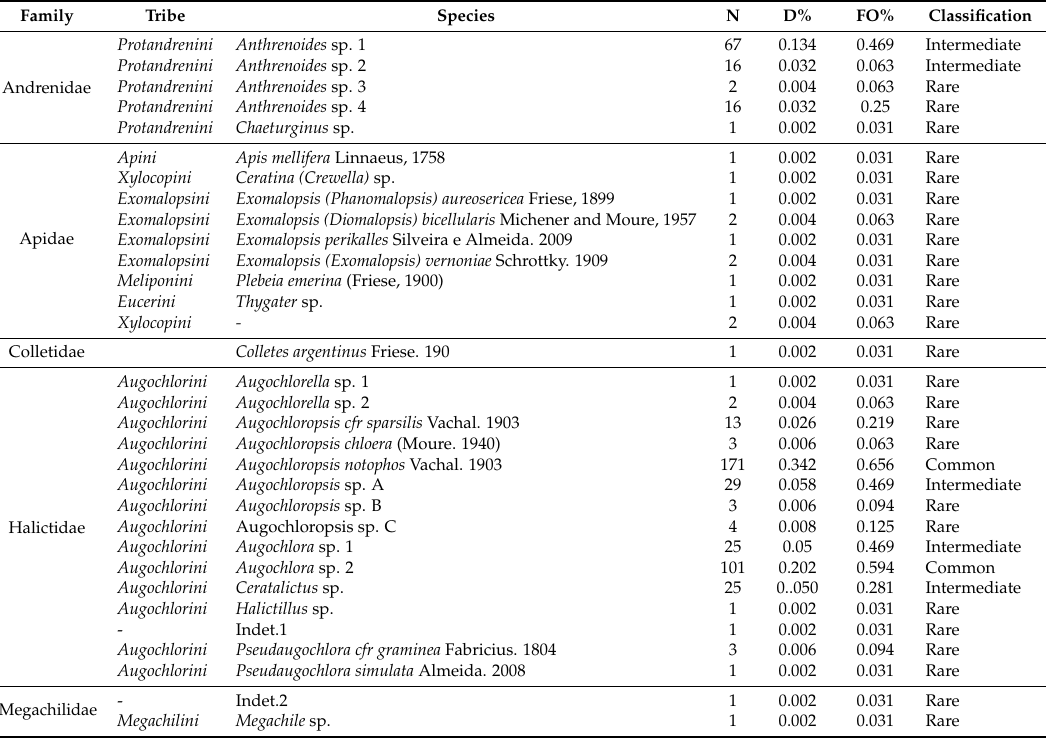
Table 1. Number of bee species on flowers of Solanum didymum (N) and their respective dominance indices (FO: species frequency of occurrence; D: species